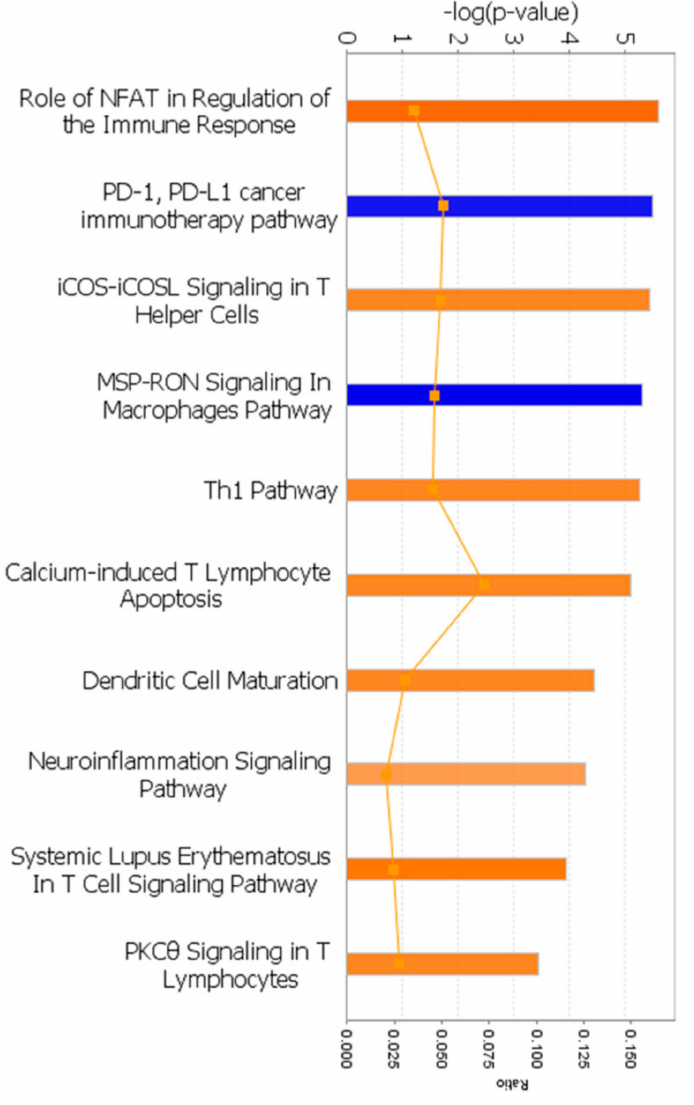
Figure 3. Canonical pathways activated (orange) or inhibited (blue) in the recGBM group. Each bar represents the pathway’s p -value on a negative logarithmic scale, such that the taller bars are more significant than the shorter bars. The ratio of the number of molecules present in the DEG list divided by the total number of molecules in the pathway is represented by the line graph